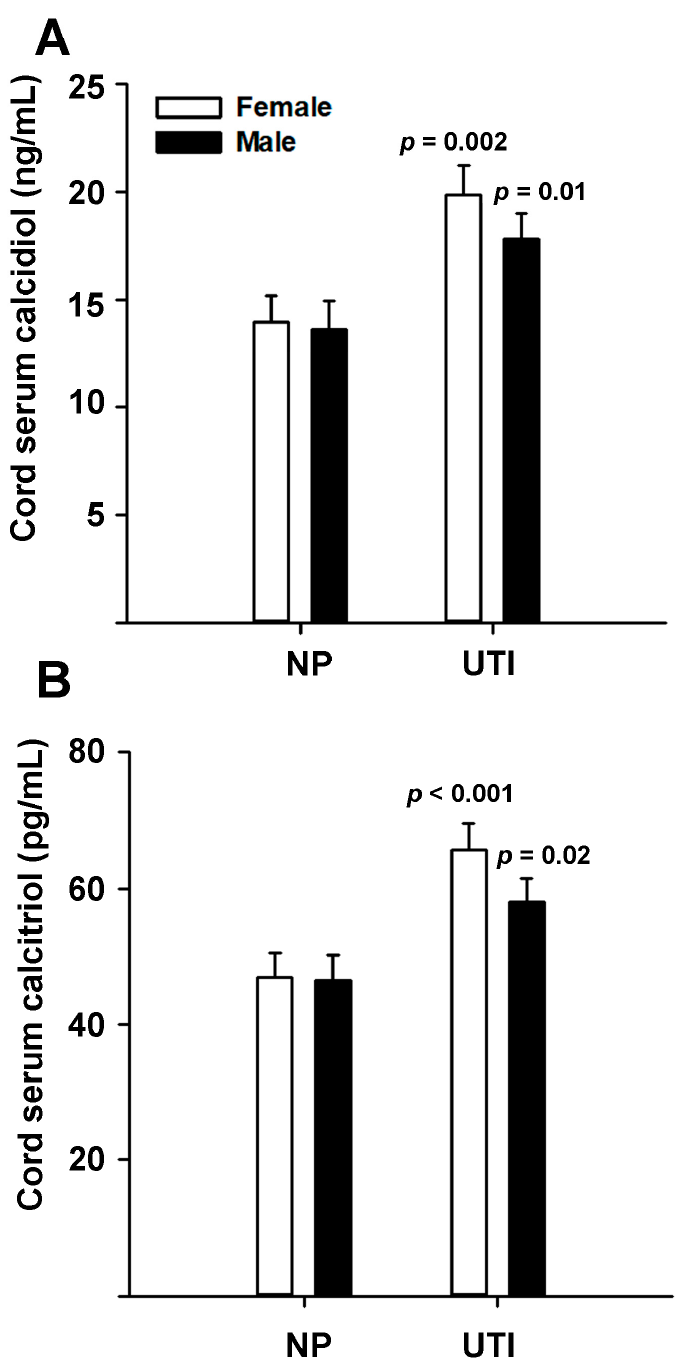
Figure 1. Vitamin D 3 metabolites in cord serum from normal and UTI-affected pregnancies. Calcidiol ( A ) and calcitriol ( B ) cord serum levels were quantified in samples from normal pregnancies (NP) and with urinary tract infection (UTI). Bars represent least-square means ± SEM. The value of p indicates the statistical significance as compared to NP samples within same sex.